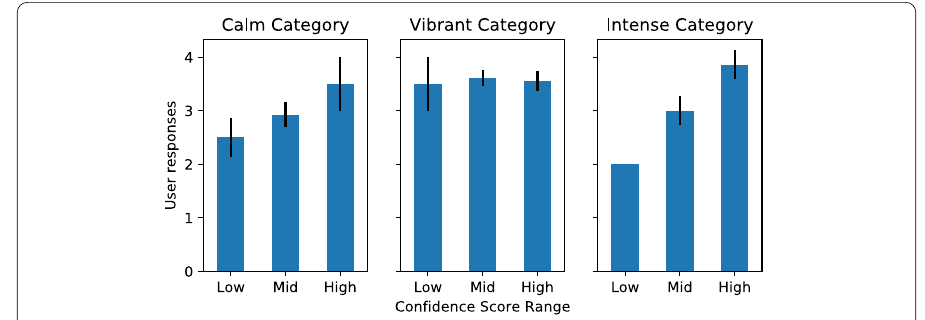
Figure 9 User ratings for songs per three confidence score ranges for each activity group. Participants rated how good the recommended songs were for a given activity group. Answers were given on a 5-point Likert scale. The confidence score range is divided into low: [0,0.33), mid: [0.34, 0.66), and high: [0.67, 1.00]. The error bars indicate the standard error of the mean. Statistical analysis detected significant differences across three confidence score ranges for the calm category and the intense category, but did not detect any significant differences for the vibrant